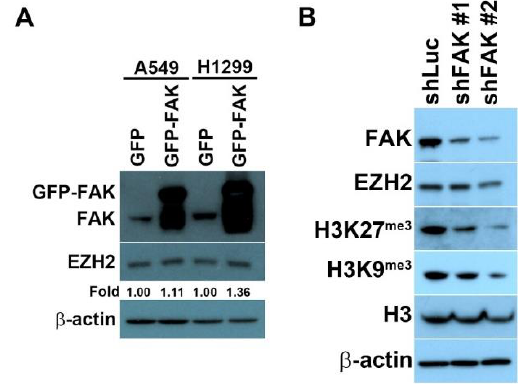
Figure 2. The manipulation of FAK expression regulates the functional roles of EZH2. ( A ) A549 or H1299 cells overexpressing GFP or GFP – FAK were lysed and subjected to Western blot analysis. The protein levels were detected using the indicated antibodies. A slight increase in EZH2 levels was detected in cells overexpressing GFP – FAK. ( B ) H1299 cells transfected with shFAK for FAK depletion were lysed and subjected to Western blot analysis. Protein levels were detected using the indicated antibodies. As a loading control, an anti- β -actin antibody was used. Western blot analysis revealed that FAK depletion decreased EZH2 expression and reduced downstream signaling, based on the assessment of the tri-methylation at Lys9 and Lys27 on histone H3.